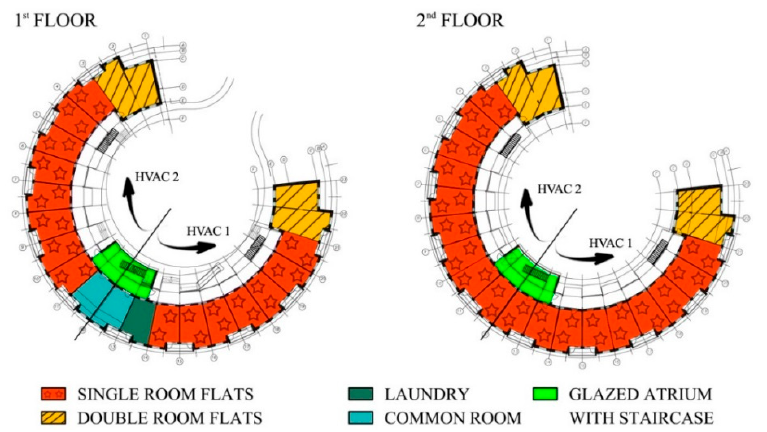
Figure 2. Layout of building, which was to be split into two similar-sized sections for experimental